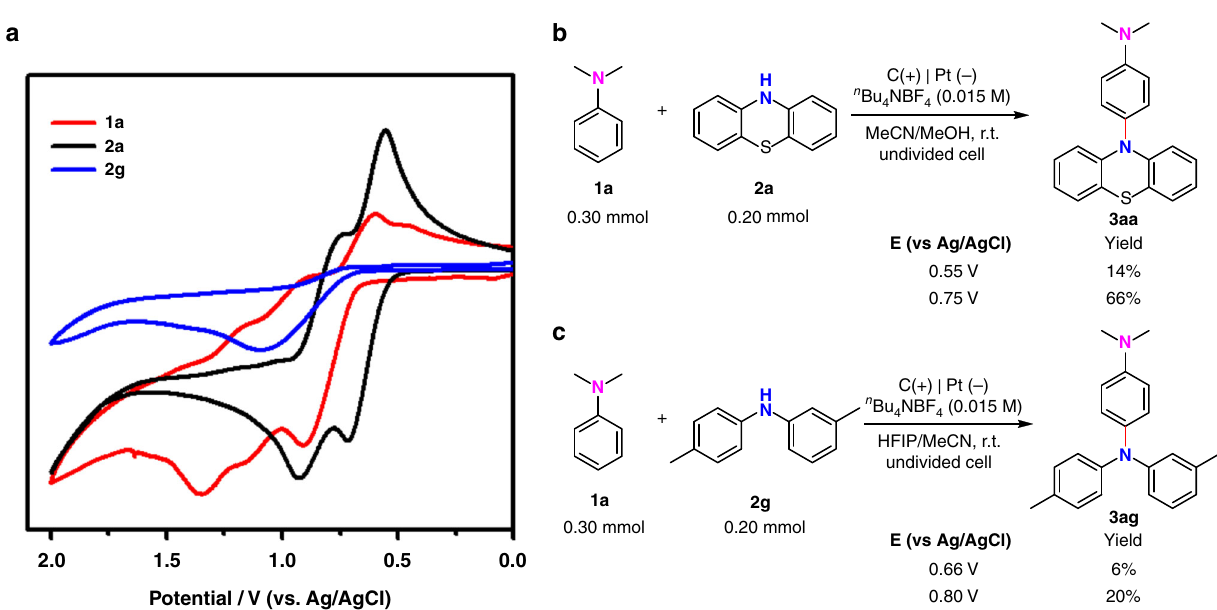
Fig. 6 Study of the oxidation potential during electrolysis. a Cyclic voltammogram on a glassy carbon electrode ( ϕ 3 mm) at 0.1 V s − 1 under nitrogen. Red line, N,N -dimethylaniline ( 1a ); black line, phenothiazine ( 2a ); and blue line, 3-Methyl-N-( p- tolyl)aniline ( 2g ). b Potential controlled electrolysis between 1a and 2a . c Potential controlled electrolysis between 1a and